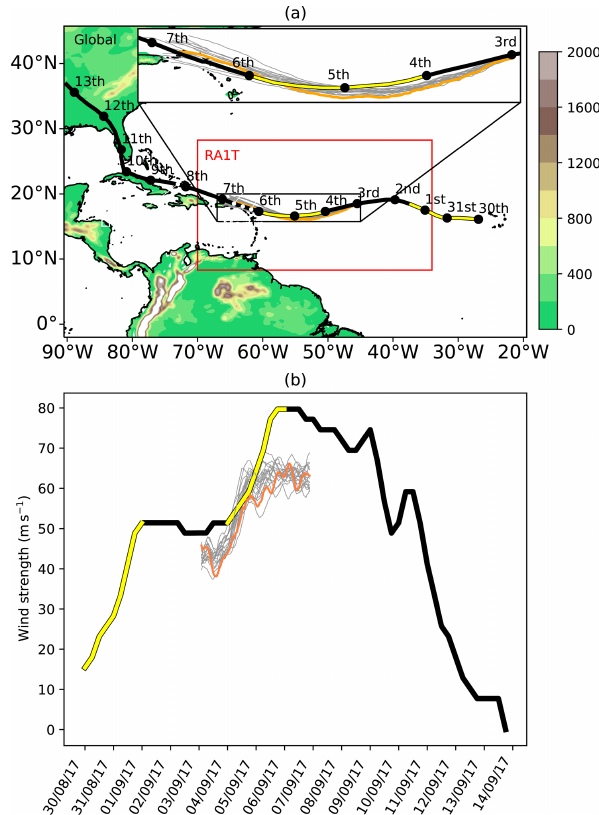
Figure 1. (a) Best track of Hurricane Irma (black line), with points corresponding to the position of Irma on each date from 30 August to 13 September 2017. Orography (m) is shown in shading. The do- main of the regional model used in this study is shown by the red rectangle. The 18-ensemble member tracks are displayed in grey, with ensemble member 15 shown in orange. Islands where land- fall occurred are indicated by white dots and labels. (b) The best track of wind speed (black); the maximum surface wind speed of the ensemble members initialised on 3 September 00:00UTC (grey contours), with ensemble member 15 highlighted in orange. In both panels periods of rapid intensification are highlighted in